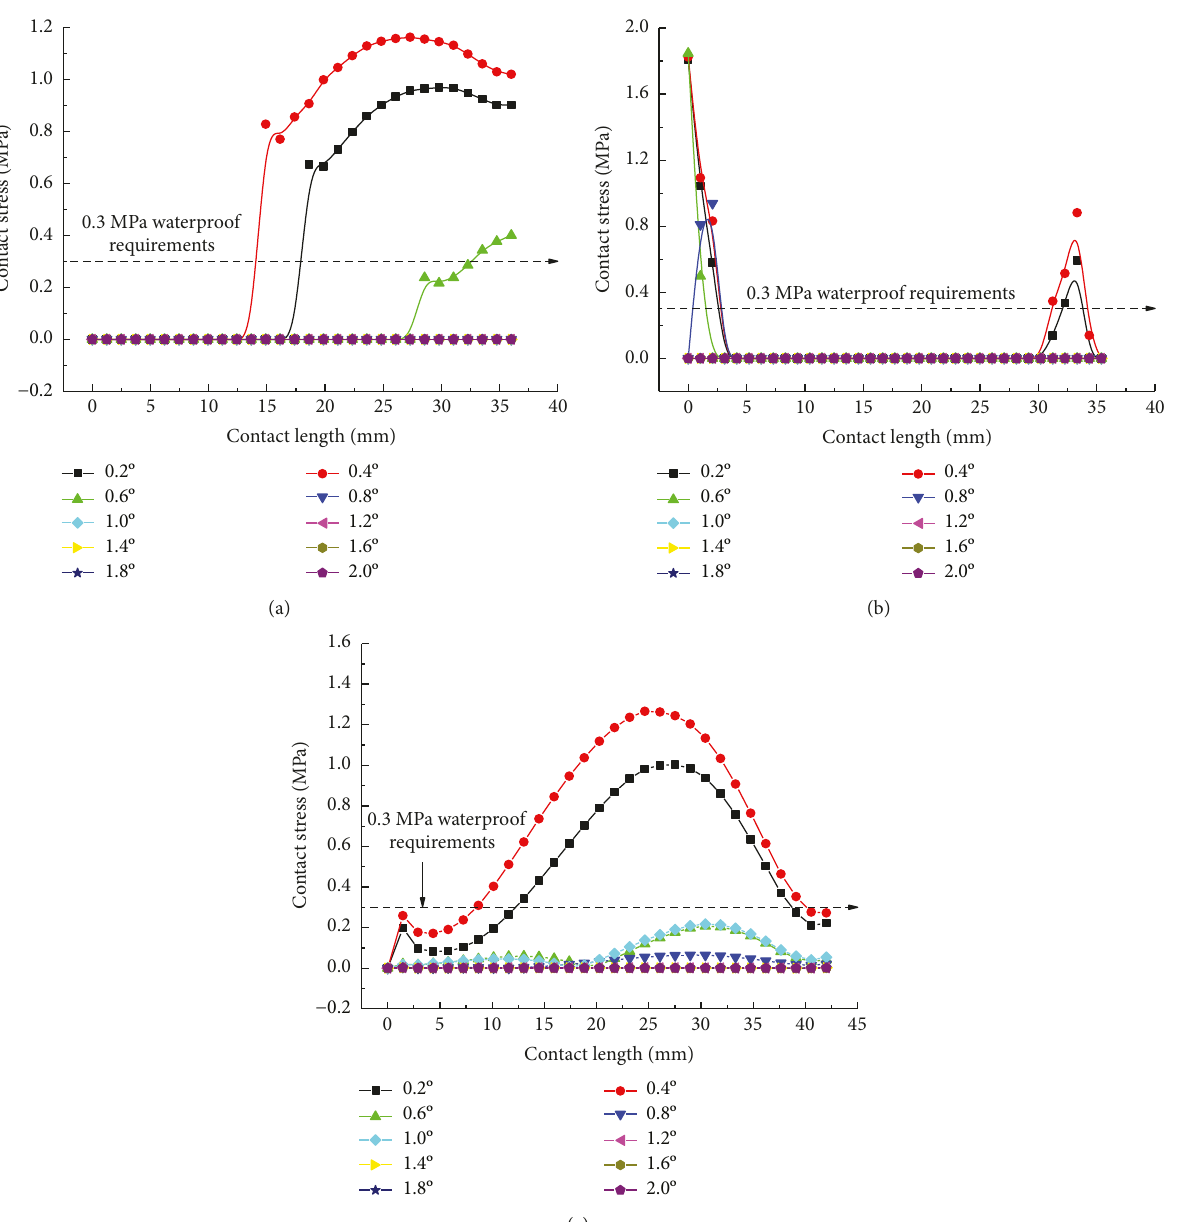
Figure 17: Contact stress curve of the second rubber ring before optimizing during clockwise rotation: (a) contact pressure of line 1 for the second rubber ring, (b) contact pressure of line 2 for the second rubber ring, and (c) contact pressure of line 3 for the second rubber